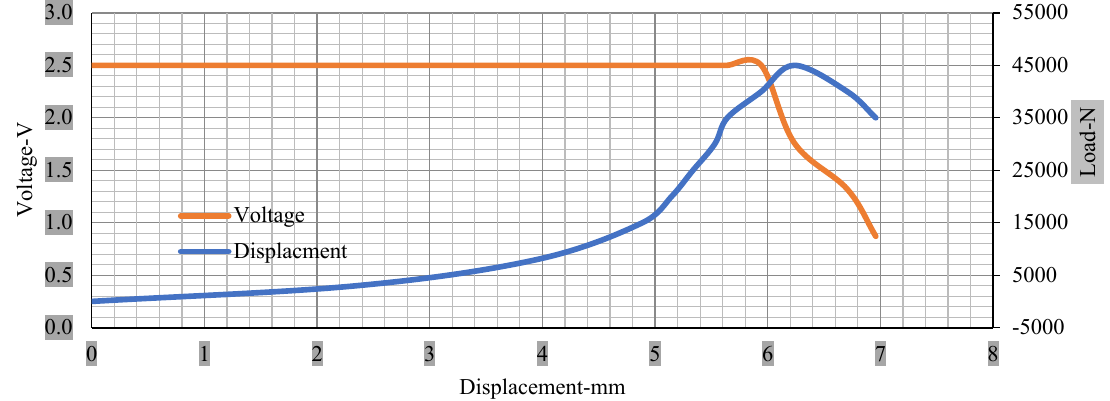
Figure 12. Load and voltage vs. displacement 28 mm punch less than 10% soc.